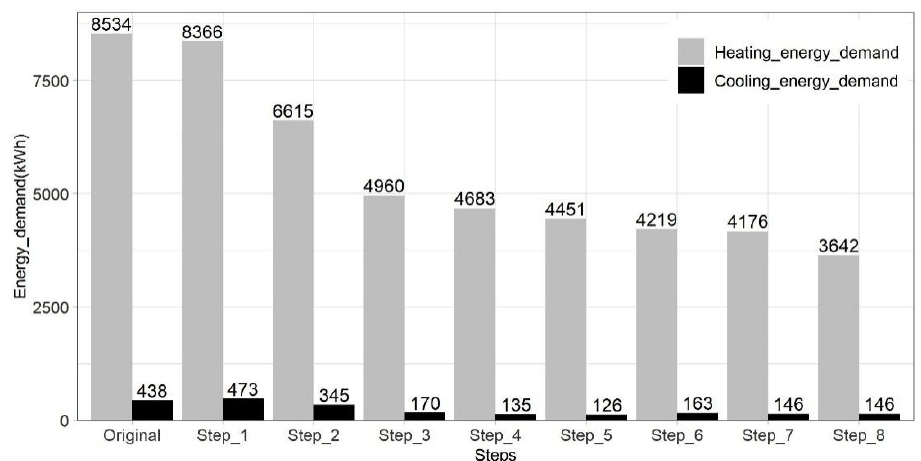
Figure 11. Annual heating and cooling energy demand according to the design of each step. Figure 10a showed the energy-saving effect of the house with different orientations.